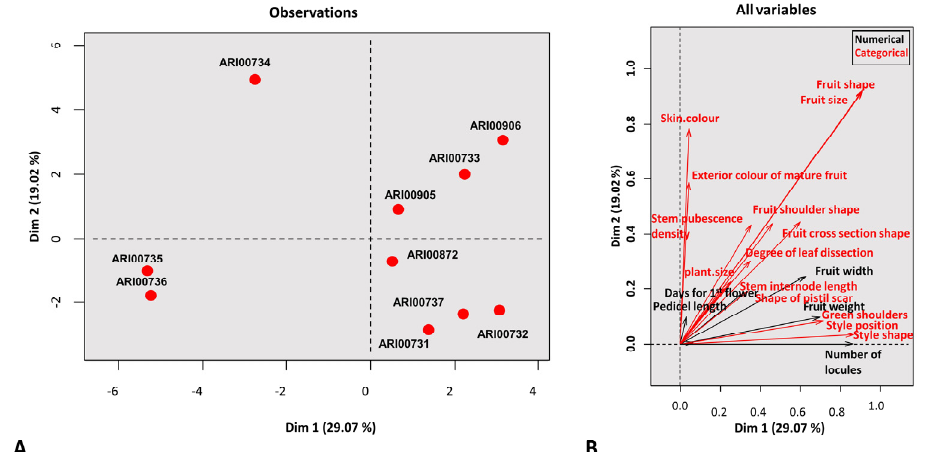
Figure 2. Principal component analysis on the two first eigenfactors based on agro-morphological descriptors ( A ). Categorical and quantitative variables explaining morphological variance across the Cypriot tomato genotypes ( B ).